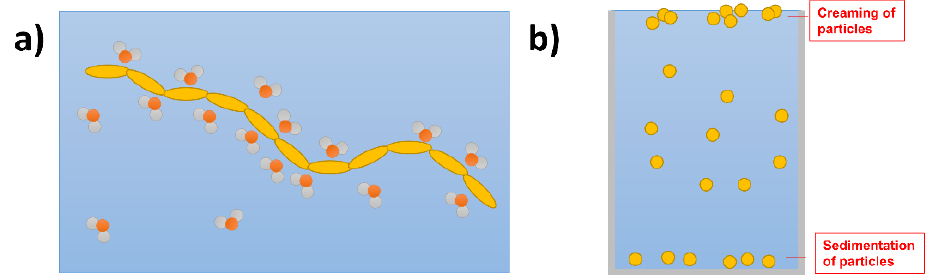
Figure 4. Interfaces in photocatalytic water splitting. ( a ) Interface of water with polymers in contact with water; ( b ) Dispersion of polymer particles, 100 nm–10 µm in size, in water. Creaming and with water; ( b ) Dispersion of polymer particles, 100 nm–10 µ m in size, in water. Creaming and sedimentation are undesired as they reduce the activity of the